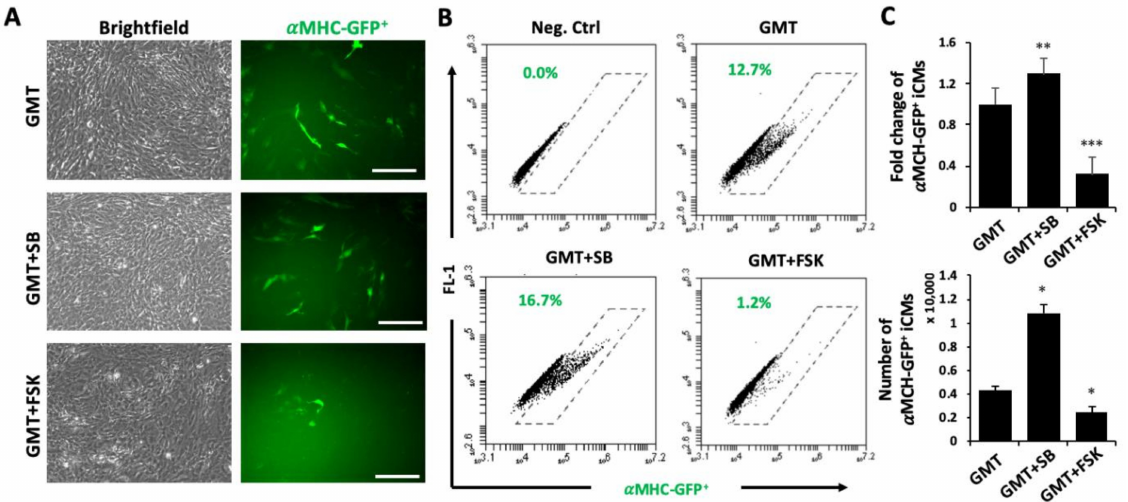
Figure 4. Forskolin inhibits iCM reprogramming of MEFs. ( A – B ) Representative brightfield (upper lane) and fluorescent (lower lane) images ( A ) and FACS plots ( B ) of α MHC-GFP + iCMs at Day8 of reprogramming with post-induction treatments of SB431542 (SB) or forskolin (FSK). Bars indicate 50 µ m. ( C ) Average fold changes of GMT-reprogrammed α MHC-GFP + iCMs by SB (1.3 ± 0.14%, n = 4, p = 0.009) or FSK (0.32 ± 0.17%, n = 4, p < 0.001). Average yield of α MHC-GFP + iCMs by GMT (4302 ± 377 cells; n = 3) was increased to 10,851 ± 759 cells (n = 3, p = 0.038) by SB but decreased to 2452 ± 507 cells (n = 3, p = 0.016) by FSK. * p < 0.05 or ** p < 0.01 or *** p < 0.005 vs. GMT